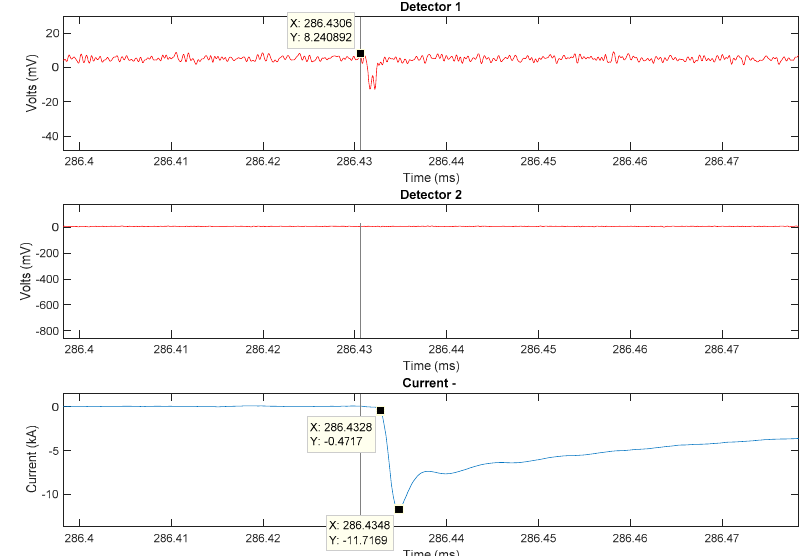
Figure 9. X-rays from a subsequent stroke of another flash occurred on 01 April, 2015. Time (ms) starting from 01:23:27.482779 UTC is given in the x-axis. The occurrence of the X-ray is about 2.2 µs prior to the onset of the current peak of the third and last RS. Flash contained two ICC pulses before the RSs. Two X-ray peaks are visible in the un-attenuated detector. The time of occurrence of the X-